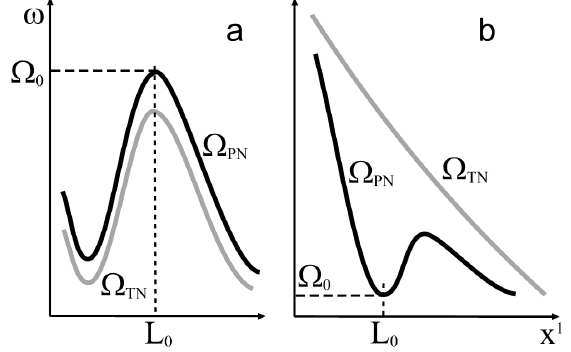
Fig. 1. Dependence of the toroidal Ω TN and poloidal Ω PN frequen- Fig. 1. Dependence of the toroidal (cid:127) TN and poloidal (cid:127) PN fre- cies on the transverse coordinate x 1 in the region of the waveguide quencies on the transverse coordinate x 1 in the region of the waveg- on the plasmapause (a) and near the ring current (b). uide on the plasmapause (a) and near the ring current (b) . Fig. 2. Structure of the wave across magnetic shells in the Alfv´en